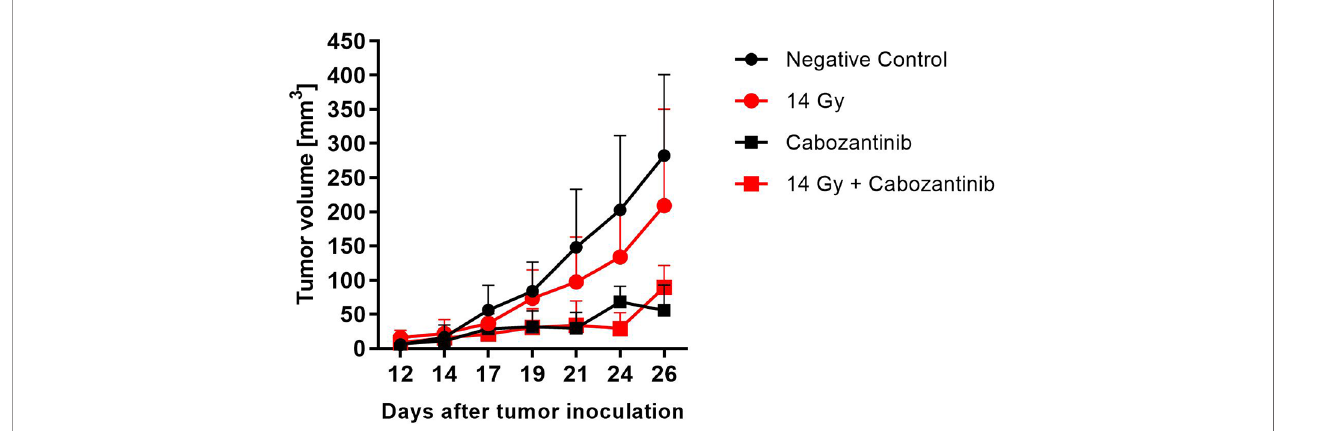
FIGURE 4 | Tumor growth after treatment with x-rays and Cabozantinib. The tumor volume was measured with a caliper and the mean value (+SD, N=8-12) is plotted against days after tumor inoculation. Mice assigned to irradiation with 14 Gy of x-rays were exposed on day 14 and those assigned to Cabozantinib